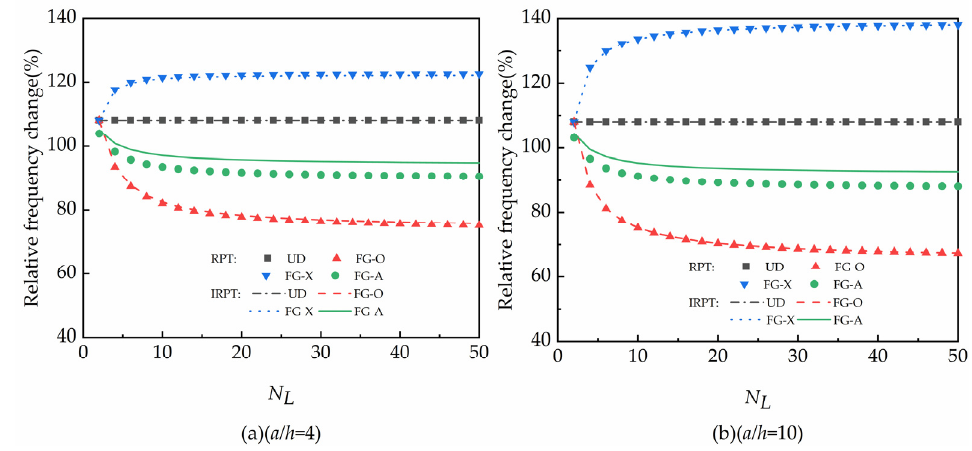
Figure 5. Relative frequency change in FG-GRC plates for / 4 a h = and / 10 a h = ( =